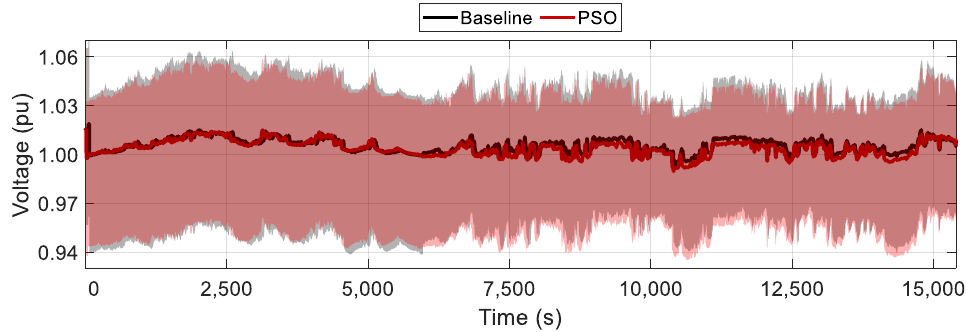
Figure 8. Comparison of Phase Voltages for PV Inverter 1 at the PCC for Baseline and PSO.